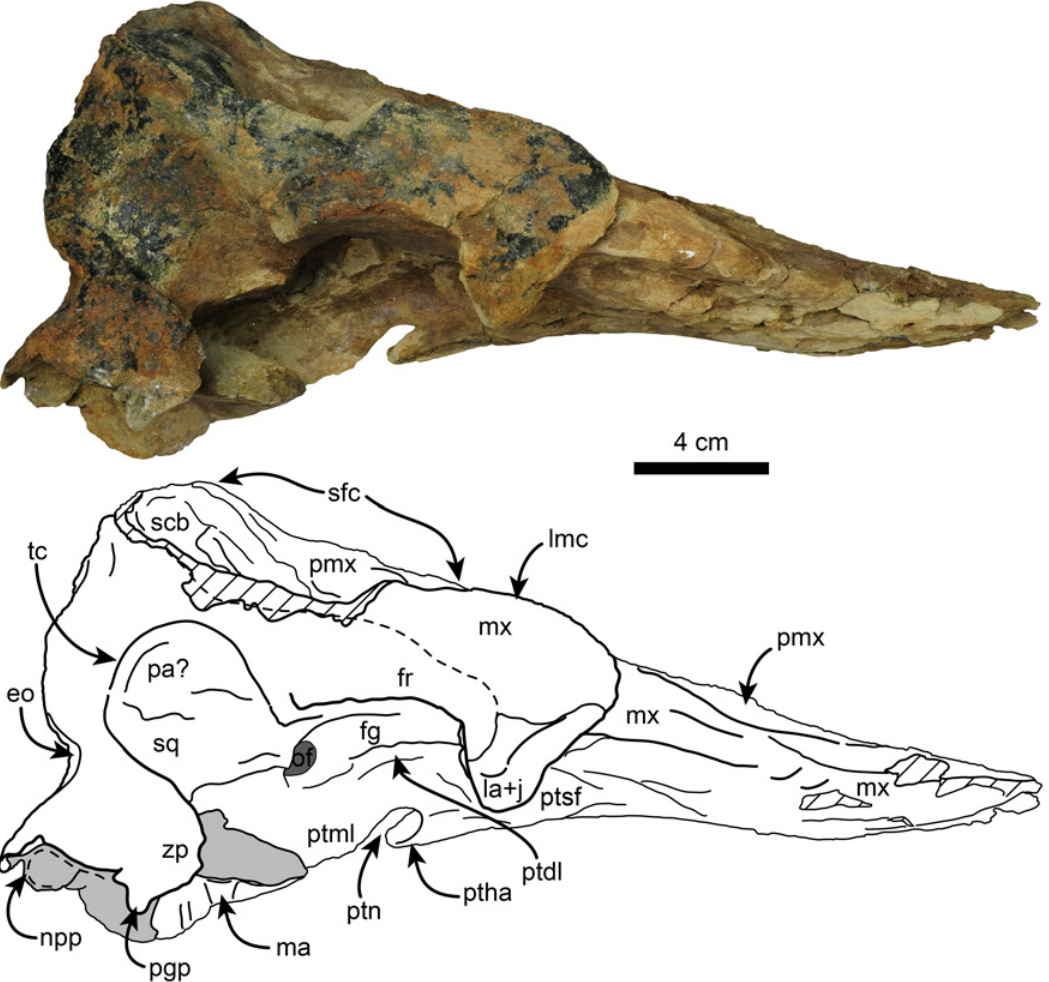
Fig 6. Right lateral view of holotype skull of Nanokogia isthmia gen. et sp. nov. (UF 280000). Abbreviations: eo, exoccipital; fg, frontal groove; fr, frontal; la+j, lacrimal + jugal; ma, mandible; mx, maxilla; lmc, lateral maxillary crest; npp, notch for posterior process of tympanic; of, optic foramen; pa, parietal; pgp, postglenoid process; pmx, premaxilla; ptdl, dorsal lamina of pterygoid; ptha, pterygoid hamulus; ptml, medial lamina of pterygoid; ptn, pterygoid notch; ptsf, pterygoid sinus fossa; scb, supracranial basin; sfc, sagittal facial crest; sq, squamosal; tc, temporal crest; zp, zygomatic process. Gray shaded areas indicate sediment; diagonal lines denote broken